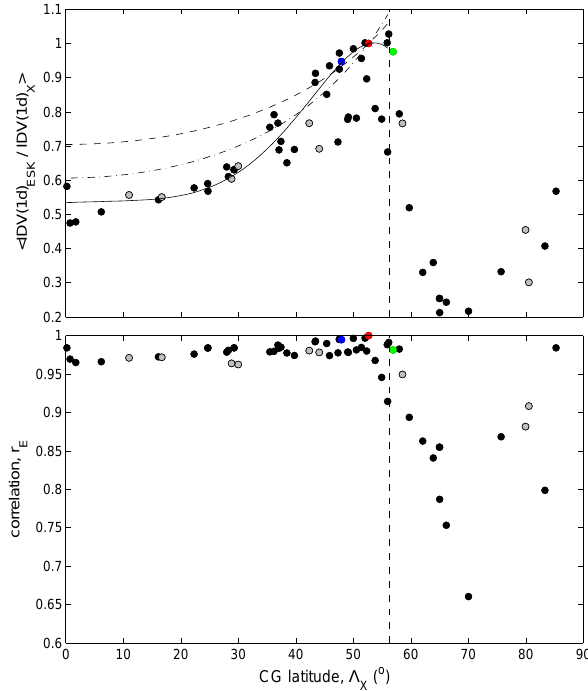
Fig. 3. Analysis of the correlations between IDV(1d) and IDV and BV n as a function of corrected geomagnetic latitude, 3 . In all three panels, open triangles are for IDV, filled circles are for IDV(1d) and black and grey for the Northern and Southern (magnetic) Hemi- sphere stations, respectively. Results for Eskdalemuir, Neimegk and Nurmijarvi are shown in red, blue and green dots, respectively. (Top) The exponent of V giving the peak correlation, n p ; (middle) the peak correlation coefficient, r p ; and (bottom) the difference be- tween r p for IDV(1d) and IDV.